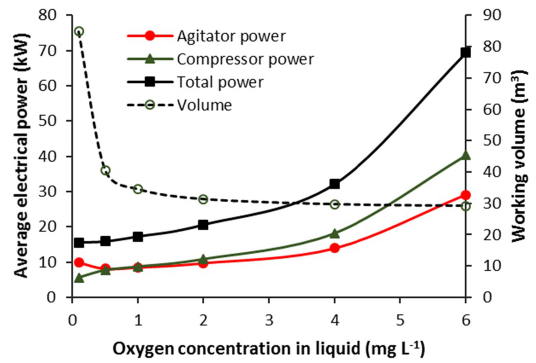
Figure 11. Effect of oxygen concentration on average power requirement for oxygen transfer and bioreactor working volume in a batch bioreactor. bioreactor working volume in a batch